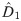
Distance contrast D^1 between the preferential attachment model and the degree matched configuration model (null model).